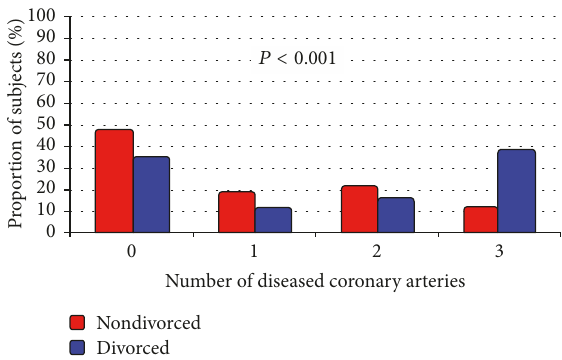
Figure 2: Number of diseased coronary arteries stratified by divorce status in